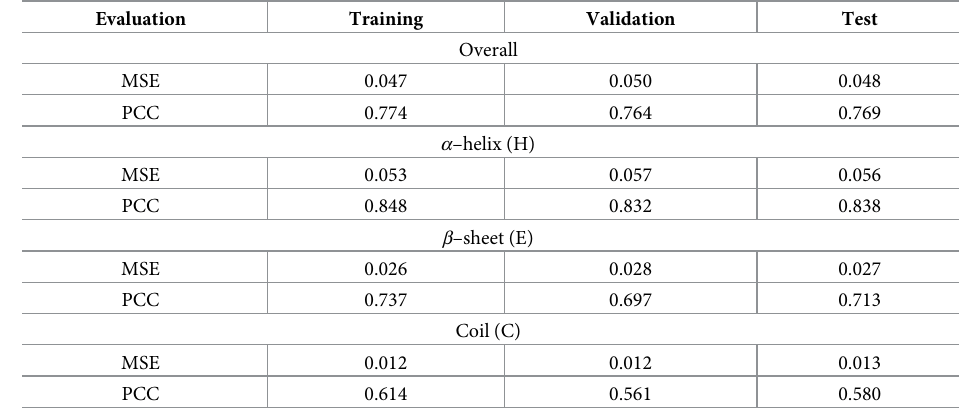
Table 1. The performance of our MCP